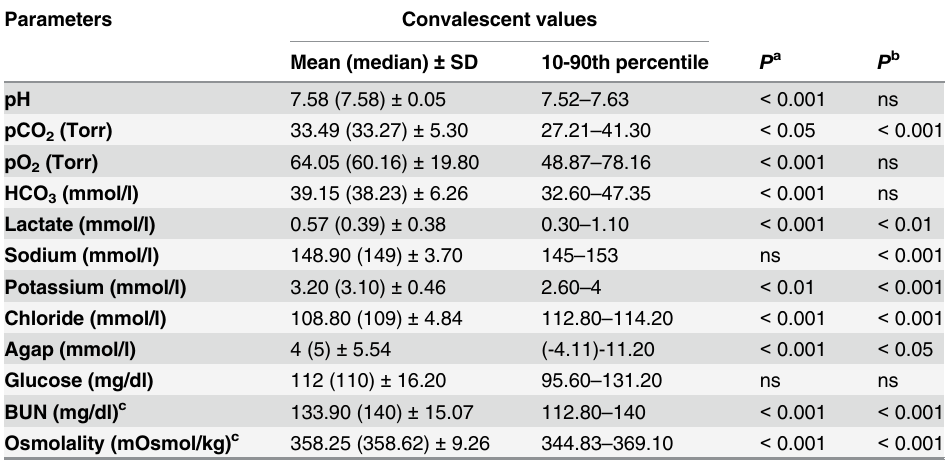
P a Statistical comparison between convalescent and admission values. P b Statistical comparison between convalescent and post fl uid therapy values. c Mean and standard deviation convalescent BUN and Osmolality underestimate the true values